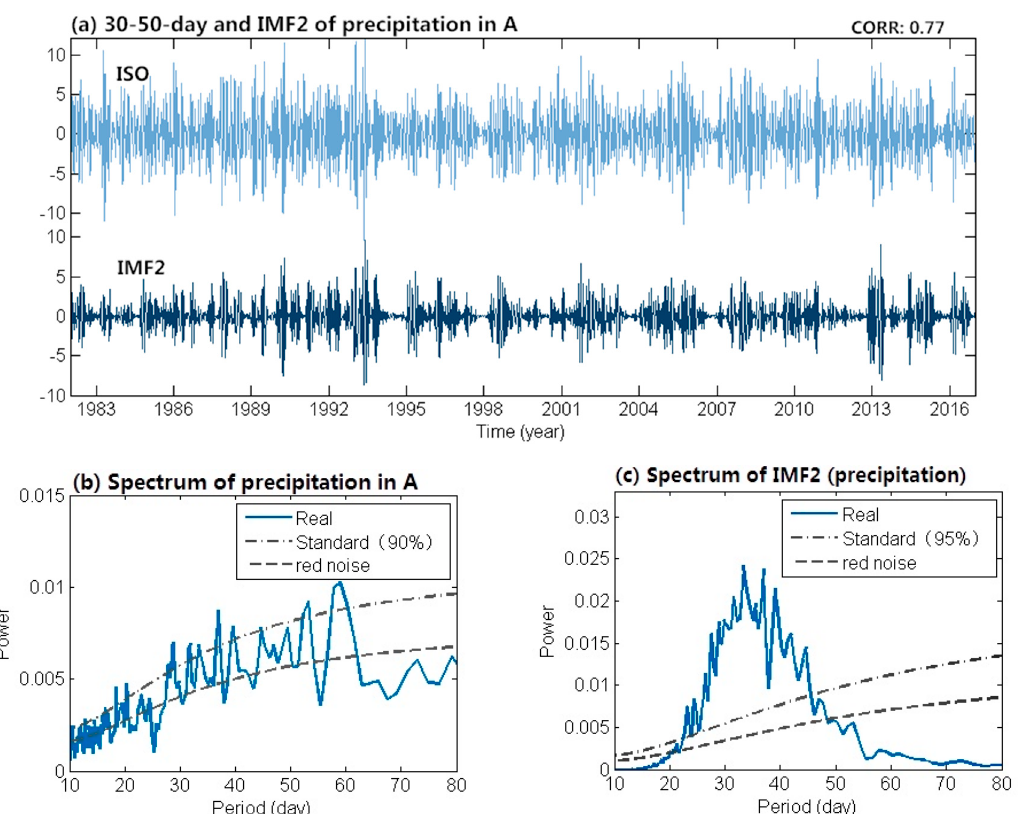
Figure 4. ( a ) The 30 – 50-day ISO (bright blue) and IMF2 (dark blue) of precipitation anomaly averaged in Region A. Correlation coefficient of the two time-series is 0.77. Spectra for: ( b ) precipitation anomaly; and ( c ) IMF2. This result exceeds 90% confidence level by student t-test. The red-noise spectrum is computed from the lag 1 autocorrelation.